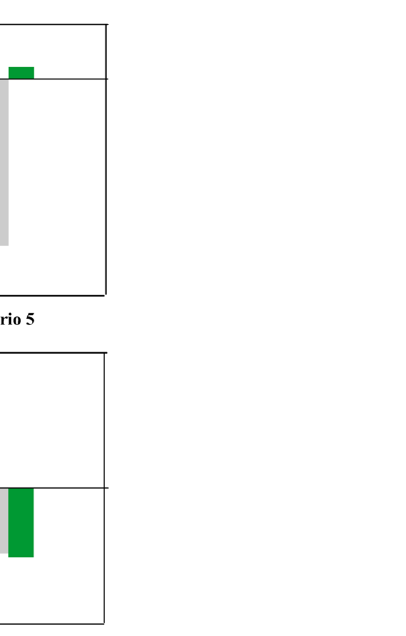
Figure 8. Average monthly groundwater recharge and water yield ( a ) and seasonal groundwater recharge fluctuation from 1990 to 2013 ( b – d ) in the Akaki River Basin.